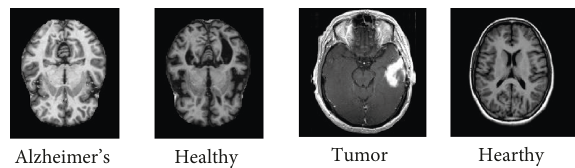
Figure 6: Samples of KACD and brain tumor